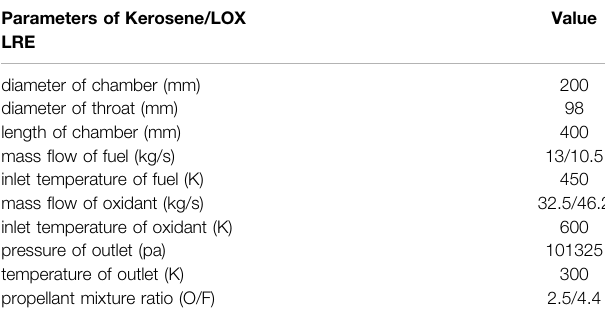
TABLE 3 | Con fi guration of chamber and initial